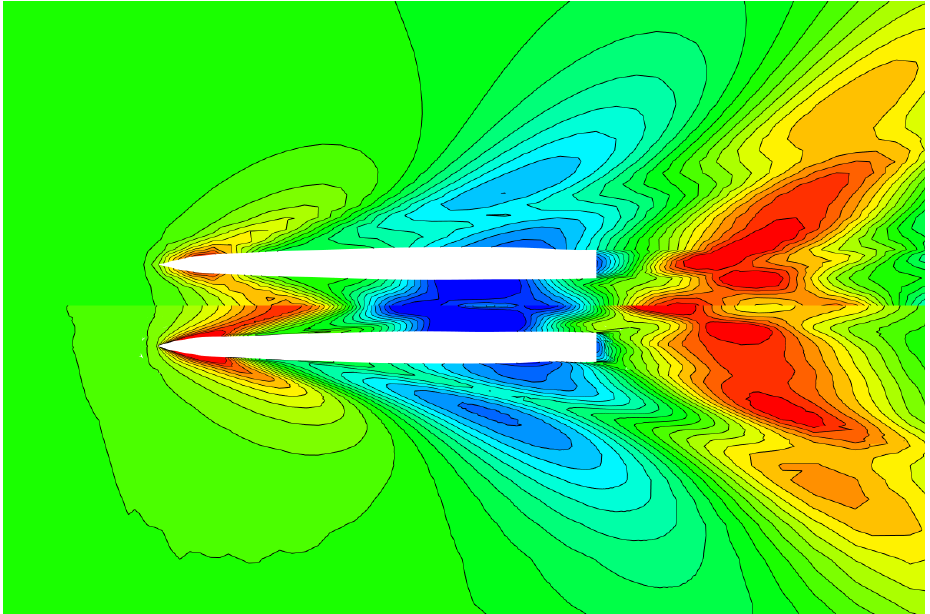
Figure 20. Free surface elevation computed for the design optimised with Shipflow (SHF-OPT) computed by SHIPFLOW (upper half of the cat’s wave pattern) and Neptuno (lower half of the cat’s wave